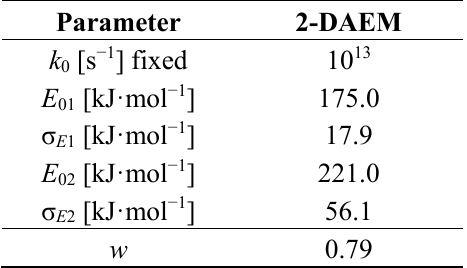
Table 4. Kinetic parameters obtained with the simultaneous fit for the biomass.